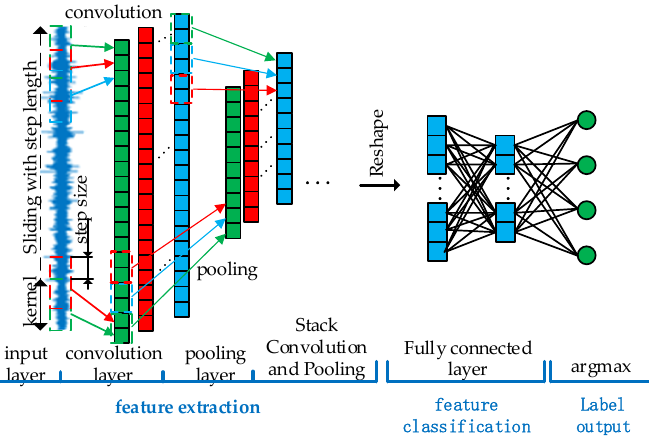
Figure 1. The structure of one-dimensional convolutional neural network.